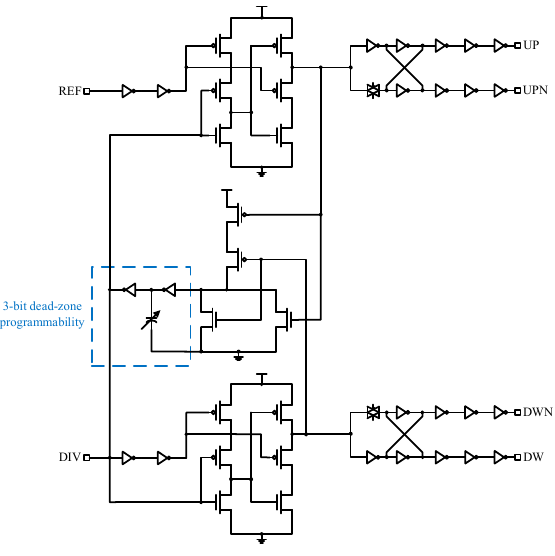
Figure 2. PFD topology.